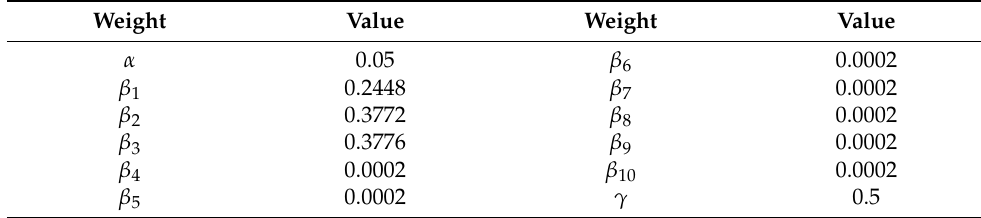
Table 2. Setting of the weight parameters in the experiment.